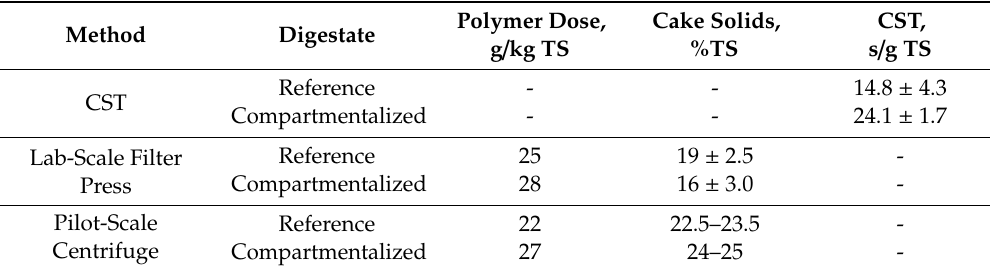
Table 3. Results of dewaterability assays of pilot-scale